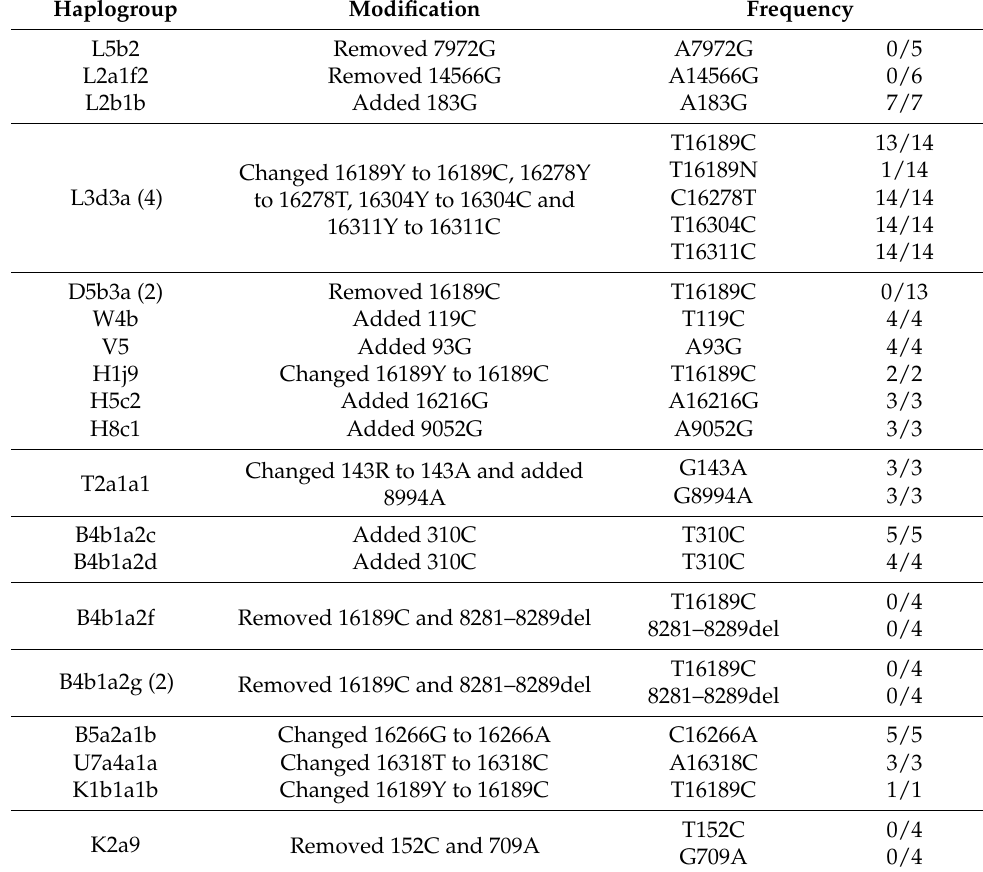
Table 6. Modified